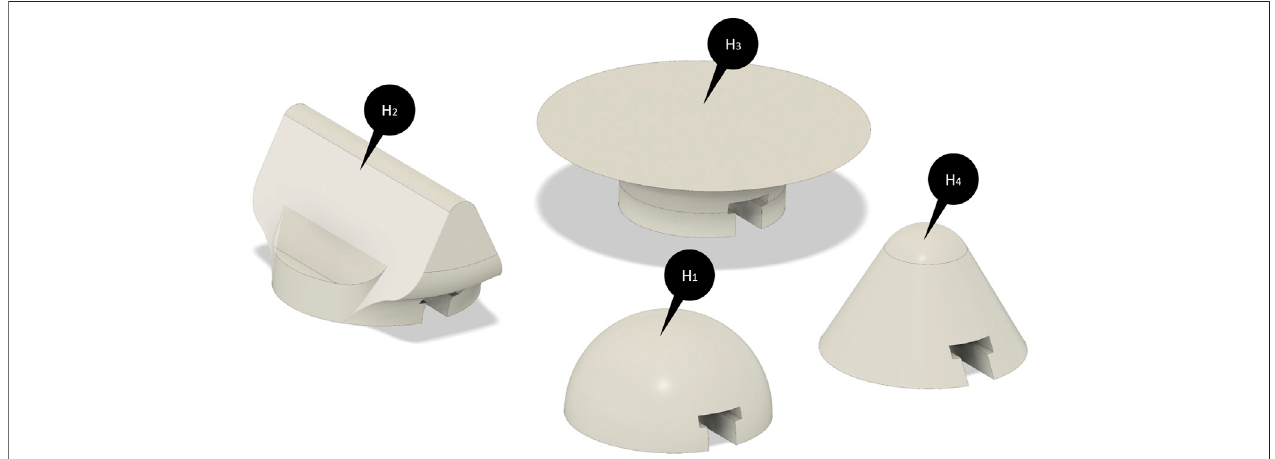
FIGURE 5 | CAD models of the end-effector ’ modules. (H 1 ) and (H 4 ) indicate the spherical modules with different radii of curvature while (H 2 ) and (H 3 ) are, respectively, the rectangular-shaped module and the plane-shaped module.